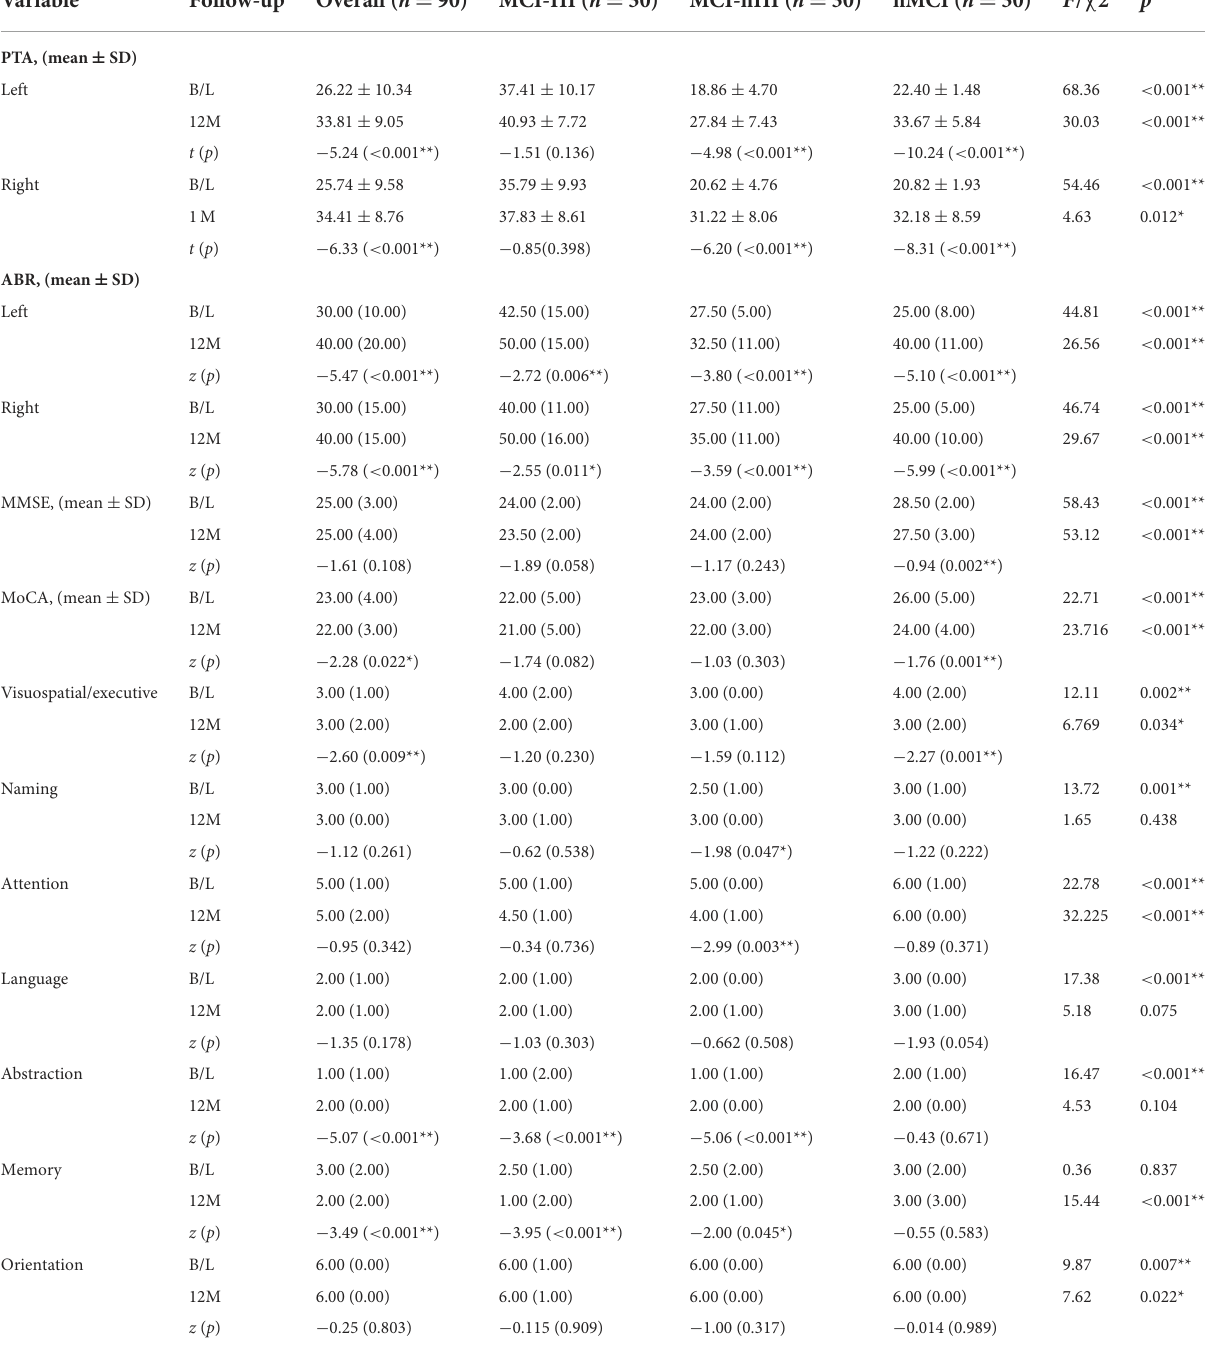
TABLE 2 Hearing and cognitive functions of participants in each group.